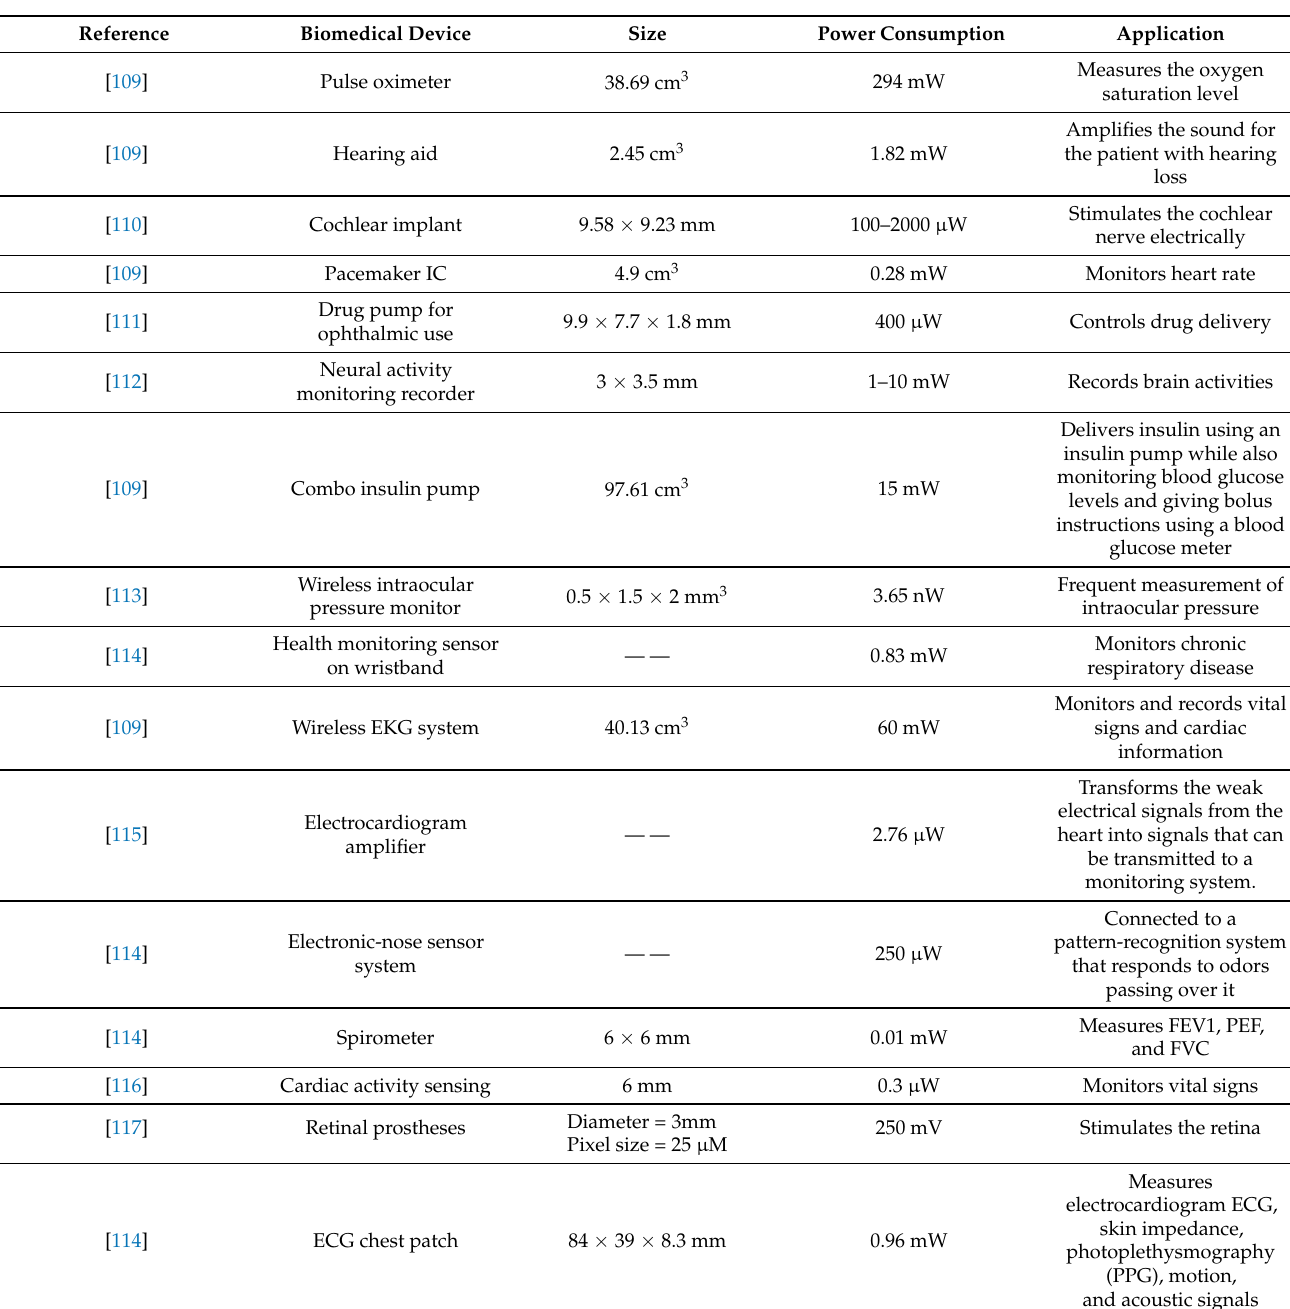
Table 4. Average power requirements and specifications of various biomedical